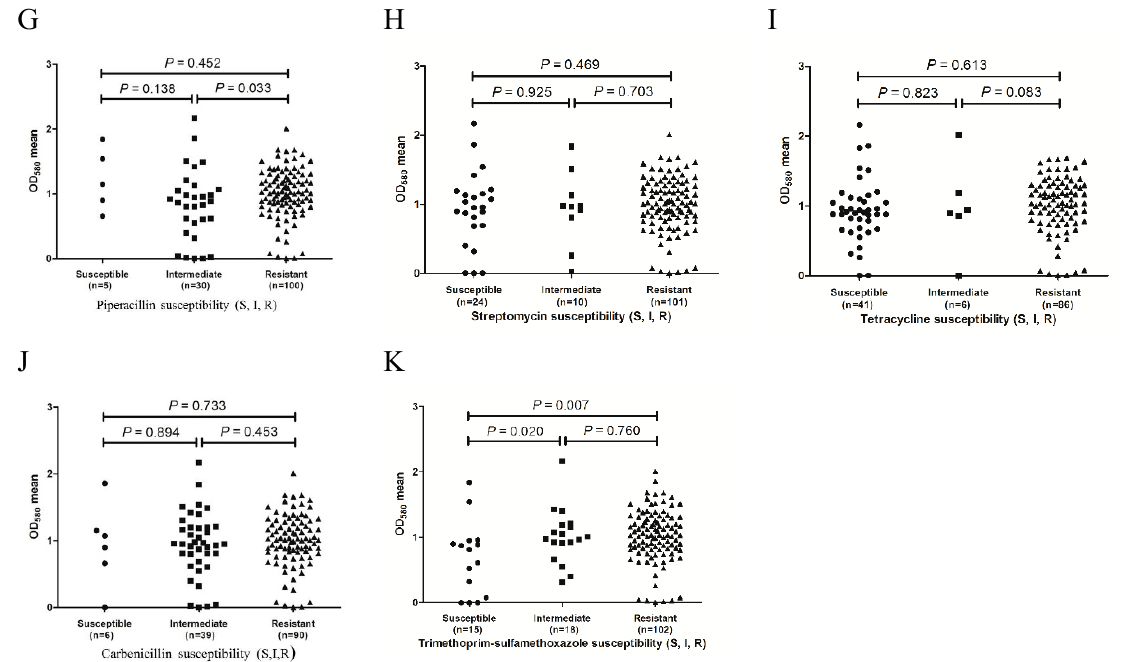
Figure 2. Distribution of biofilm formation of the isolates with di ff erent antibiotic resistance phenotypes. ( A ), amikacin susceptibility; ( B ), ticarcillin susceptibility; ( C ), ceftazidime susceptibility; ( D ), cefepime susceptibility; ( E ), gentamicin susceptibility; ( F ), imipenem susceptibility; ( G ), piperacillin susceptibility; ( H ), streptomycin susceptibility; ( I ), tetracycline susceptibility; ( J ), carbenicillin susceptibility and ( K ), sulfamethoxazole / trimethoprim susceptibility.